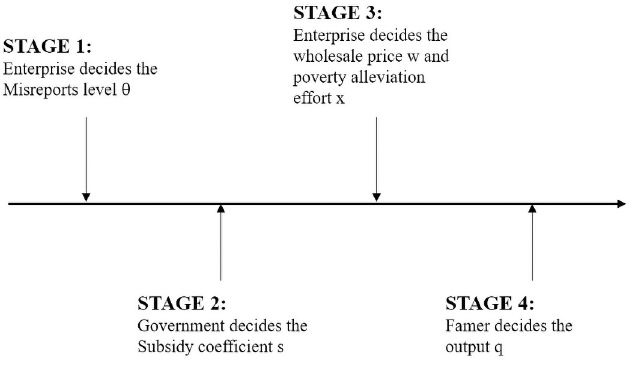
Fig 1. Decision order of supply chain